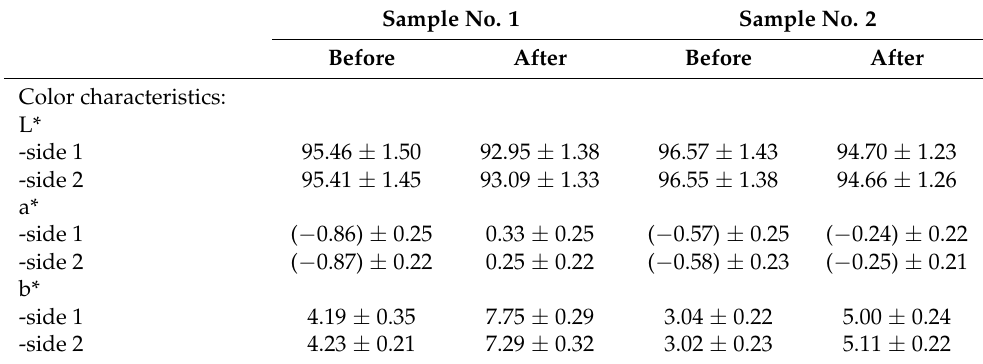
Table 6. Color characteristics of paper sample nos. 1 and 2 before and after modification. Sample No. 1 Sample No. 2 Before After Before